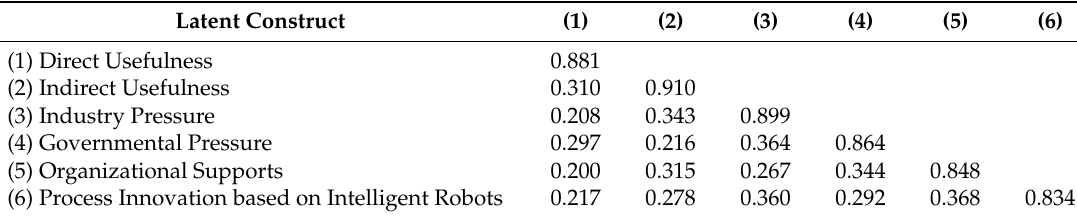
Table 4. Discriminant validity